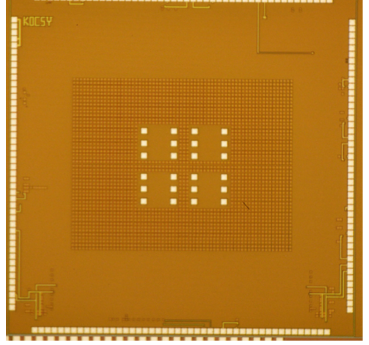
Figure 9. Photo of the fabricated chip.